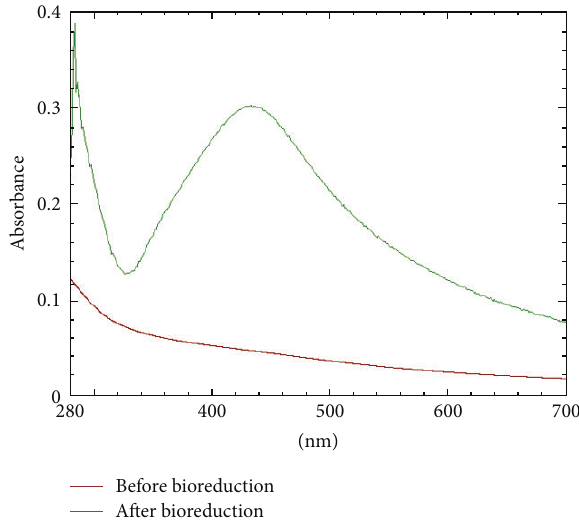
Figure 2: The UV/Vis absorption spectra of silver nanoparticles. nm: wavelength in nanometers (1 unit = 100nm); Abs: absorbance (1 unit = 0.1 absorbance